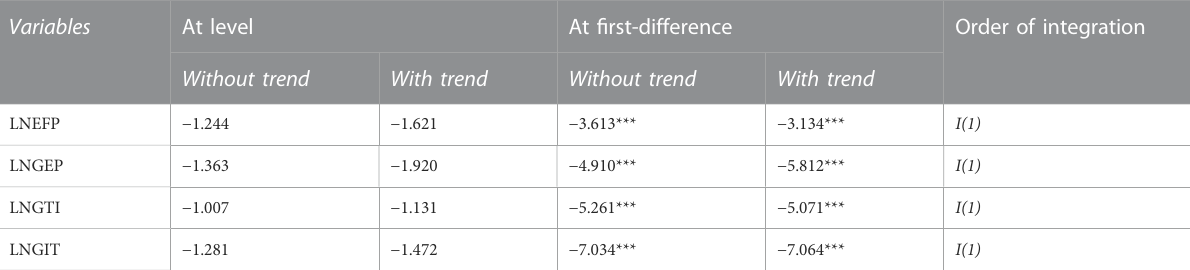
TABLE 4 Unit root test of Second generation.